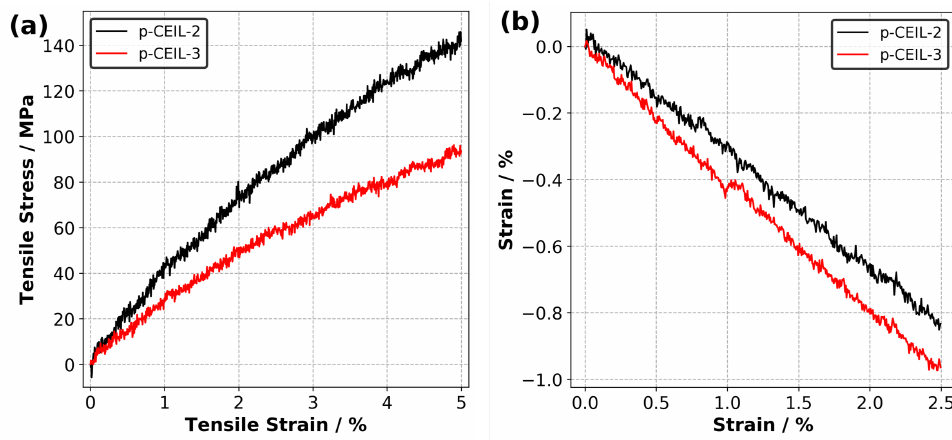
Figure 7. ( a ) Predicted tensile stress versus tensile strain plots and ( b ) strain versus strain plots for p-CEIL-2 and p-CEIL-3 obtained at 27 ◦